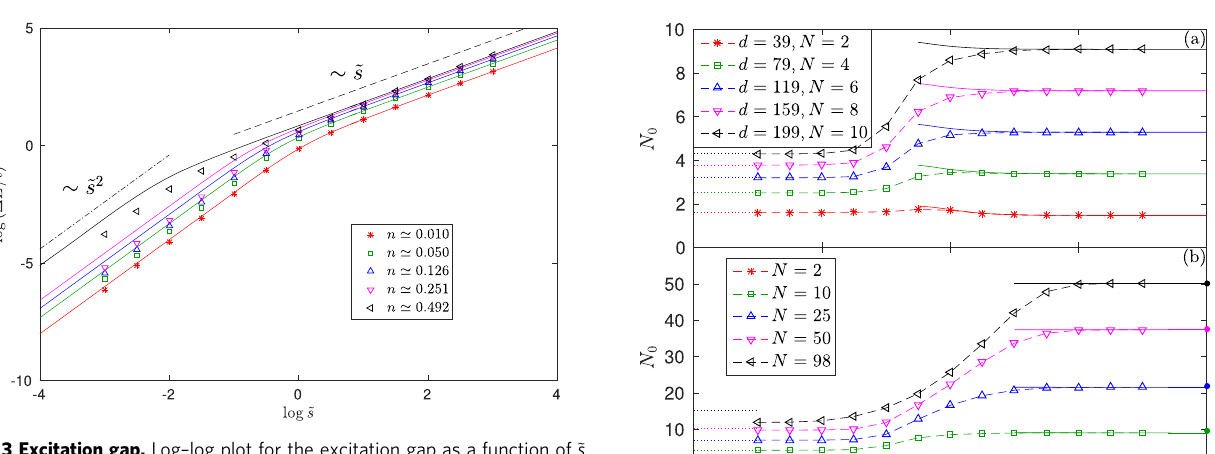
Fig. 3 Excitation gap. Log – log plot for the excitation gap as a function of ~ s for d = 199 and various fi lling factors n . Results from density matrix renormalization group calculations (symbols) and the analytical result (Eq. (4)) (solid lines). The dashed-dotted and dashed lines represent slope two and one, respectively. Fig. 4 Number of condensed bosons. a